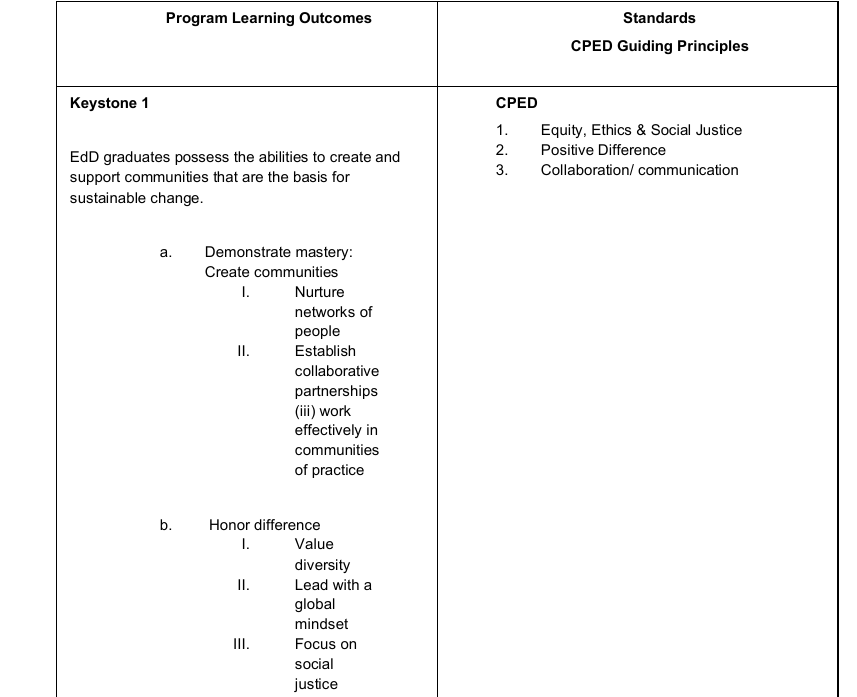
Table 3. Alignment of EdD Program Keystones with CPED Guiding